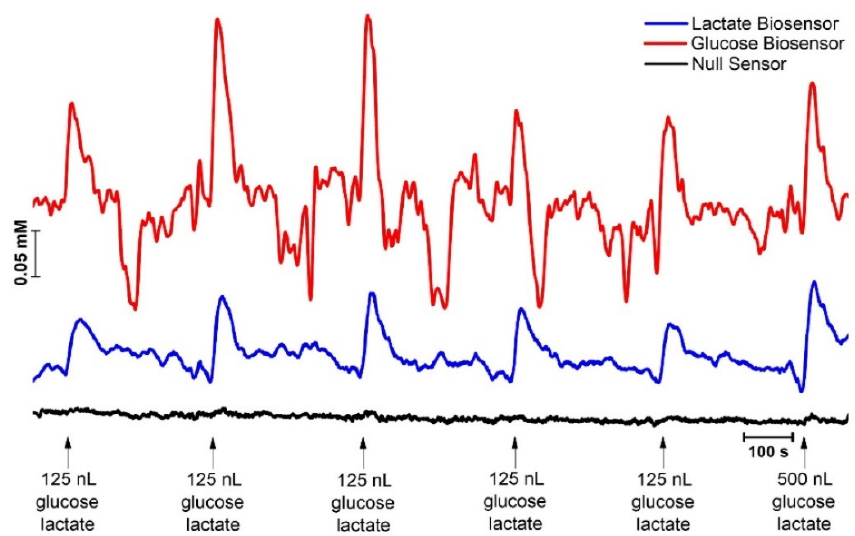
Figure 5. In vivo recording of lactate (blue) and glucose (red) in the cortex (AP: − 4.0; ML: − 2.5; DV: − 1.5). Black line represents current recorded at the null sensor. Arrows indicate moment of pressure ejection (1 s, 20 PSI) of a sodium lactate and glucose solution (0.1 mM) from a micropipette placed at 150 µm from the recording microelectrodes. Current to concentration conversion was accomplished with resource to pre-calibration sensitivity, since no significant loss in sensitivity was observed in the post-experiment calibration performed after 4 h of implantation in brain tissue.